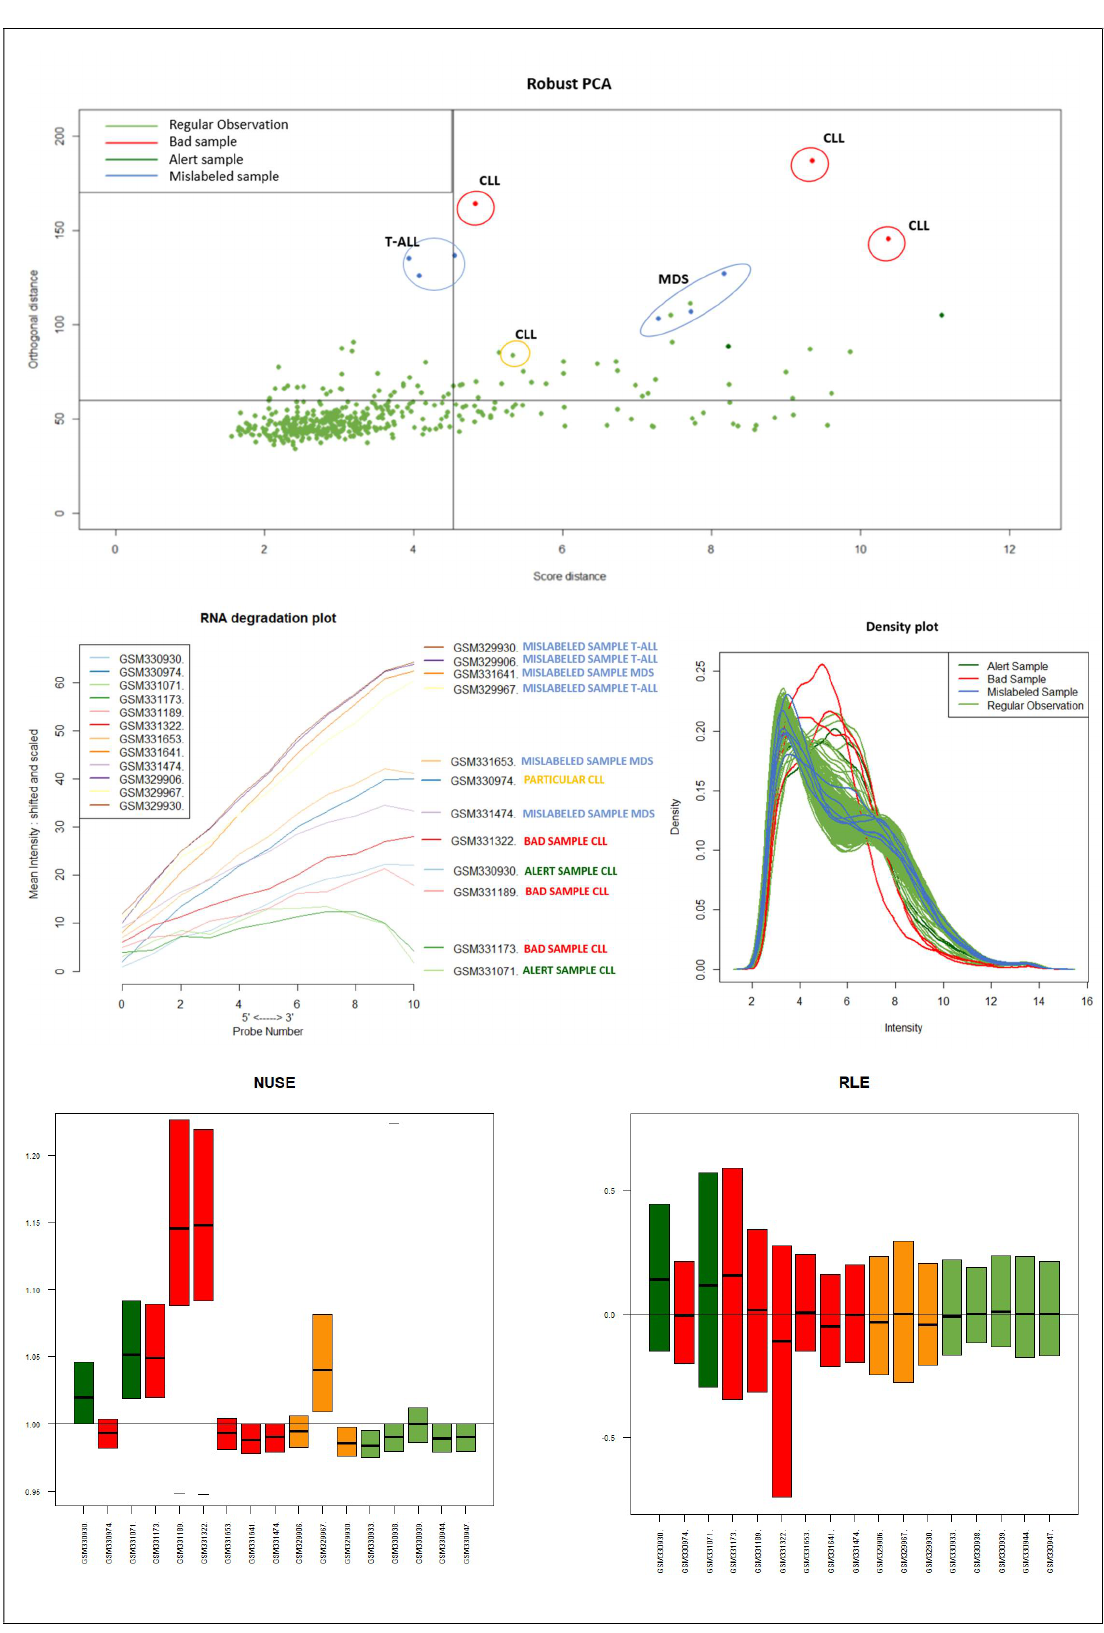
Figure A4. Summary of quality array measures for Dataset